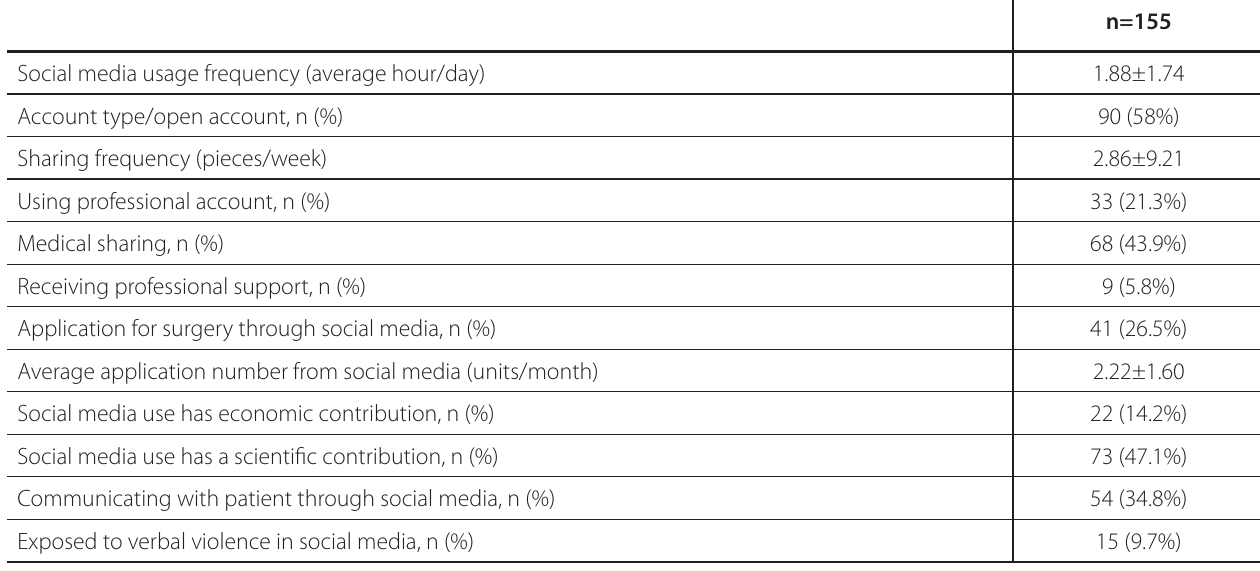
Table 1 . Results among the cardiovascular surgeons using social